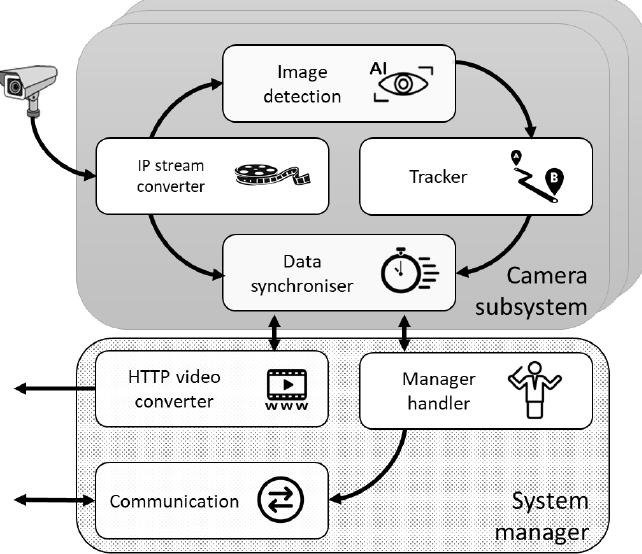
Figure 13. Camera network system — overview.